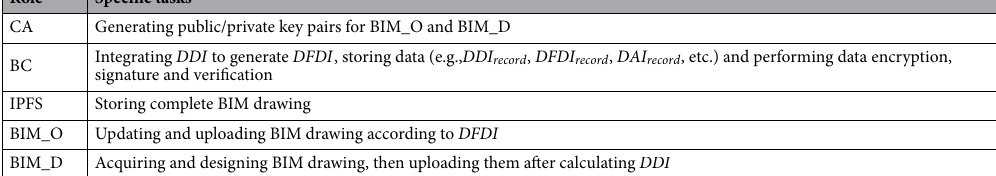
Table 3. The specific tasks of each role within the logical framework.